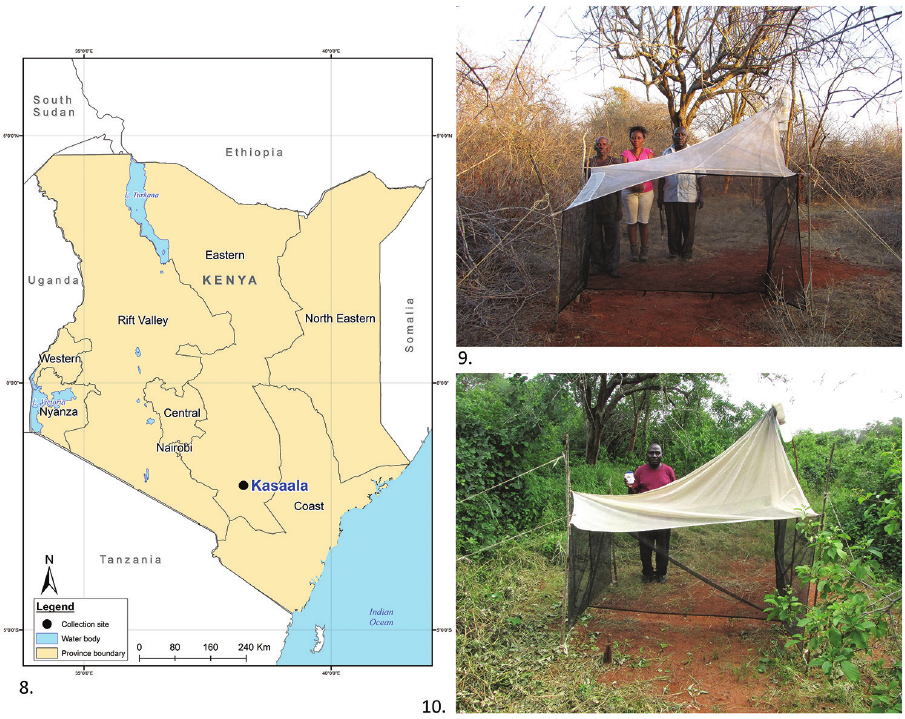
Figure 8–10. 8 Map of collecting site in Kasaala, Kenya 9–10 Malaise trap where Hedychridium buffing- toni Kimsey & Copeland was collected in the dry season ( 9 ) and wet season ( 10